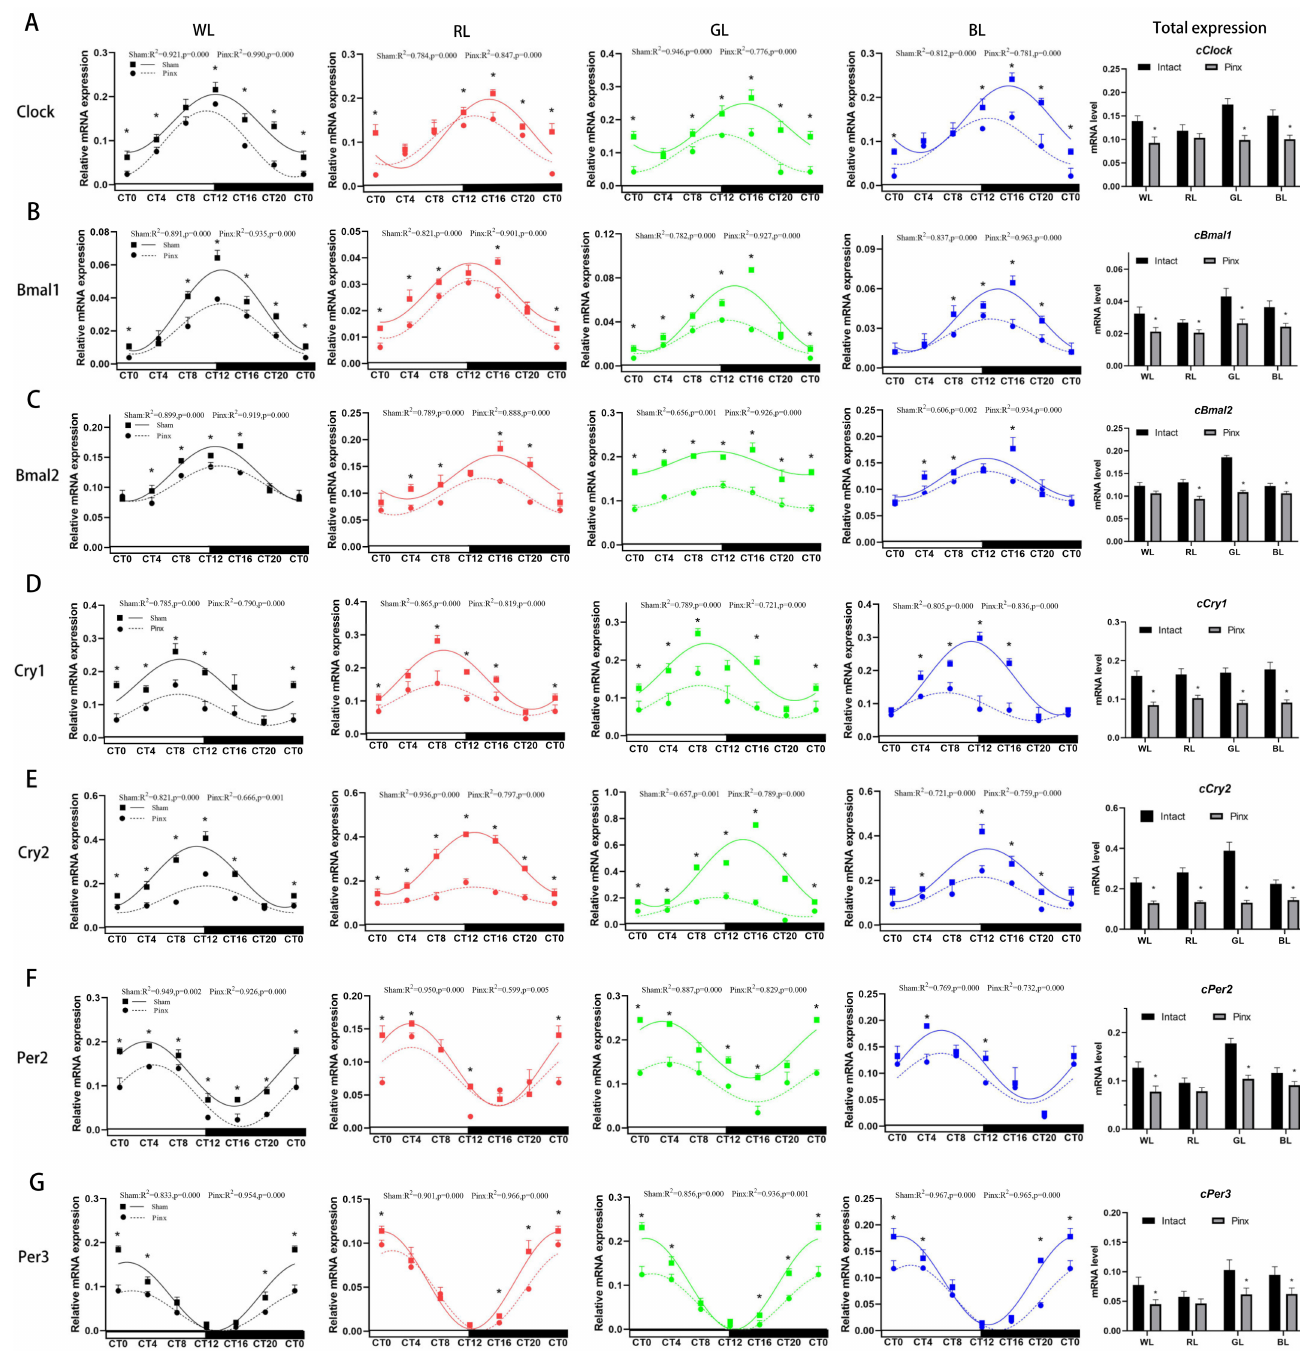
Figure 5. Circadian rhythms of pancreas clock gene transcription in chicks after pinealectomy. The dashed line with circle symbols represents the circadian rhythm in the pinealectomy group, and the solid line with square symbols represents the circadian rhythm in the sham operation group.